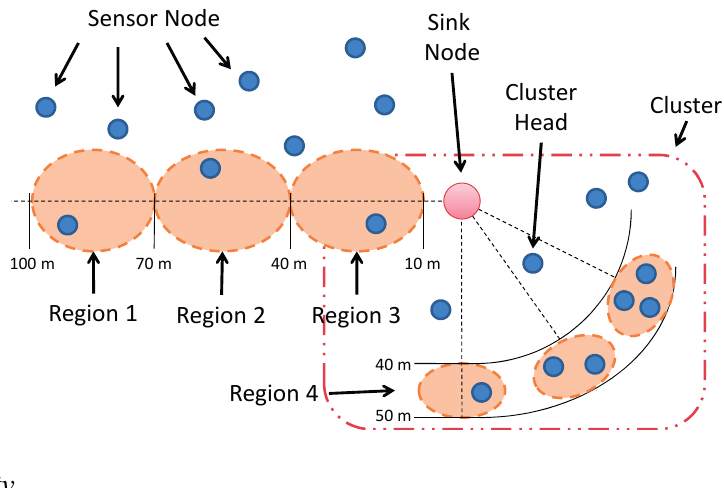
Figure 17. General overview of the three